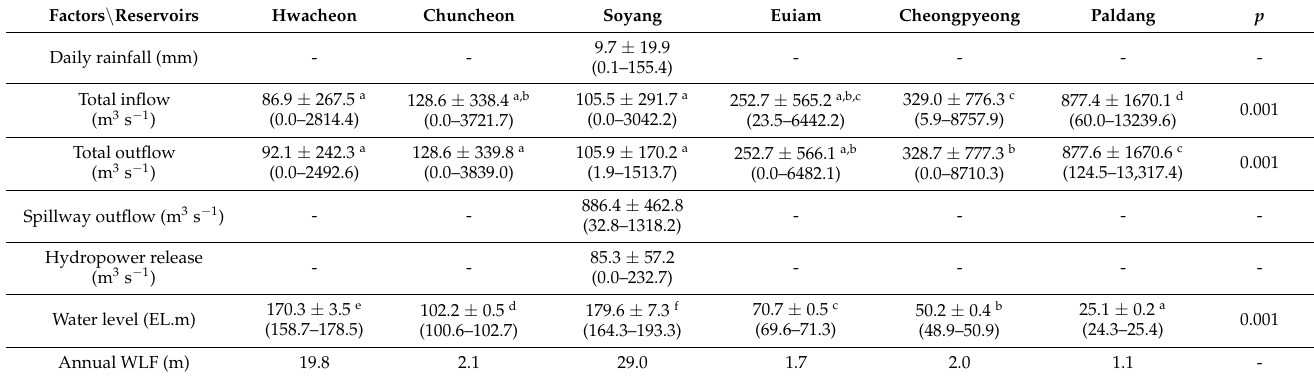
Table 1. Descriptive statistics of the hydrological factors determined in six reservoirs located on the North Han River and Han River systems from January to December 2011. The values indicate means, standard deviations, and ranges (minimum and maximum). The results of Tukey’s test are represented by a – f , where stations with different letters are statistically different from each other ( a > b > c > d > e > f ) and stations with the same letters are statistically